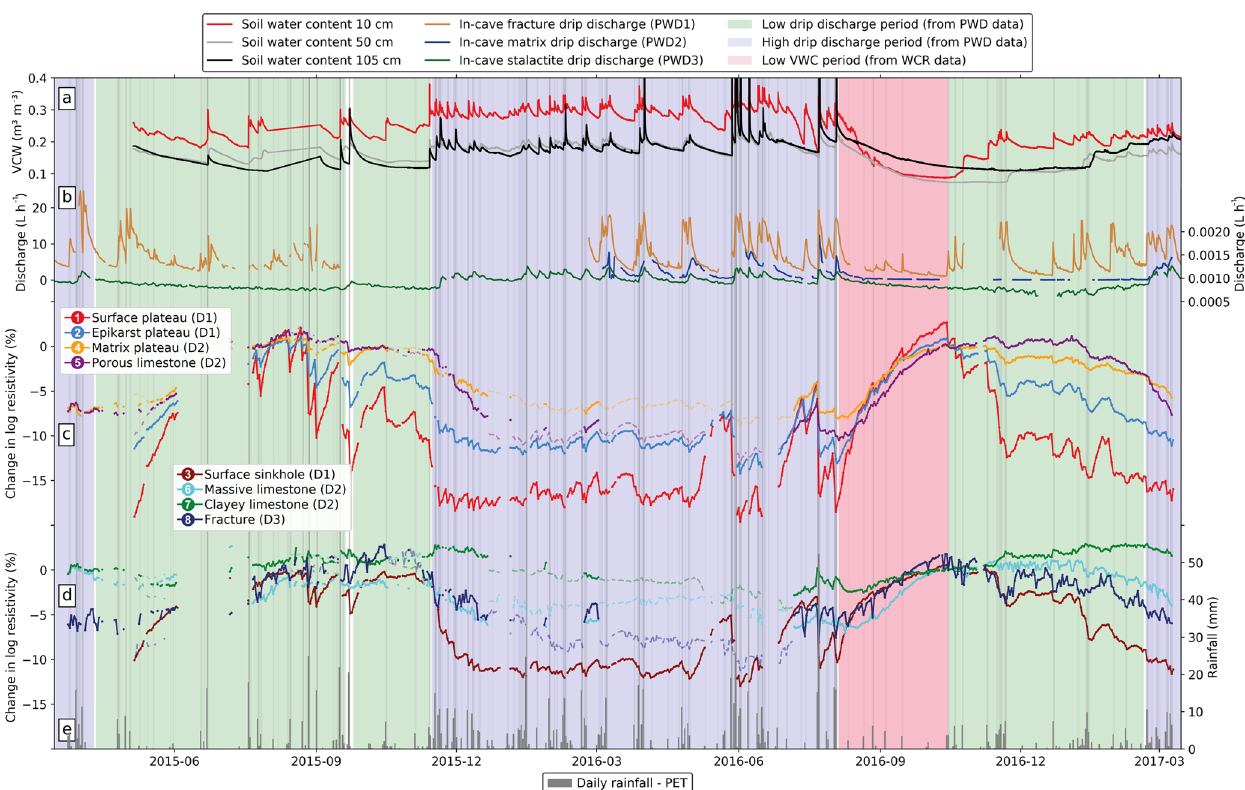
Figure 13. (a) VWC data sets for the 10, 50 and 105cm deep WCR probes. (b) Percolating water discharge of the PWD1, PWD2 (left y axis) and PWD3 (right y axis) data sets. (c) and (d) Evolution of changes in log resistivity relative to dry period (15 October 2016) for the eight regions from Fig. 7. (d) Daily effective rainfall. Daily rainfall greater than 3mm is also included as spans in the whole figure (transparency as a marker of rainfall intensity) as well as dry and wet periods from Fig.